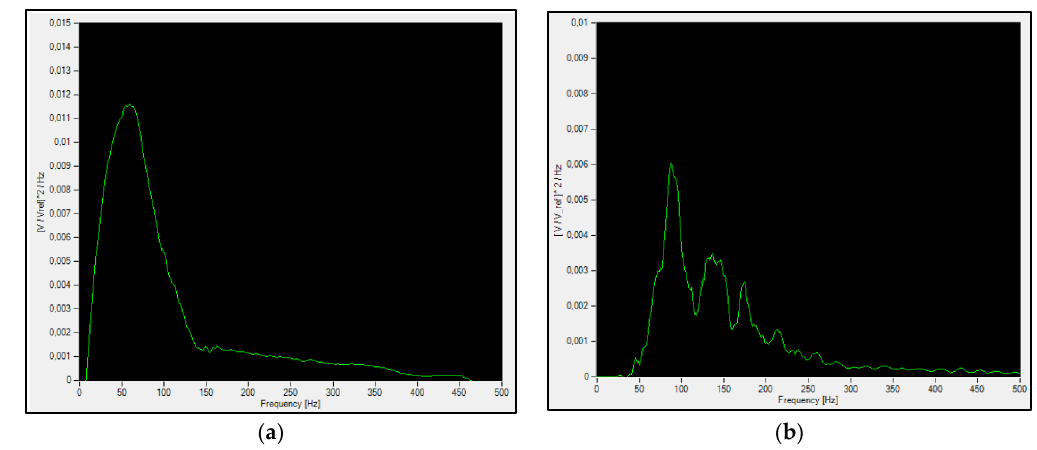
Figure 3. Spectral analysis of the sEMG signal of the vastus lateralis muscle in an exercise of squat ( a ) and a single repetition in squat jump exercise ( b